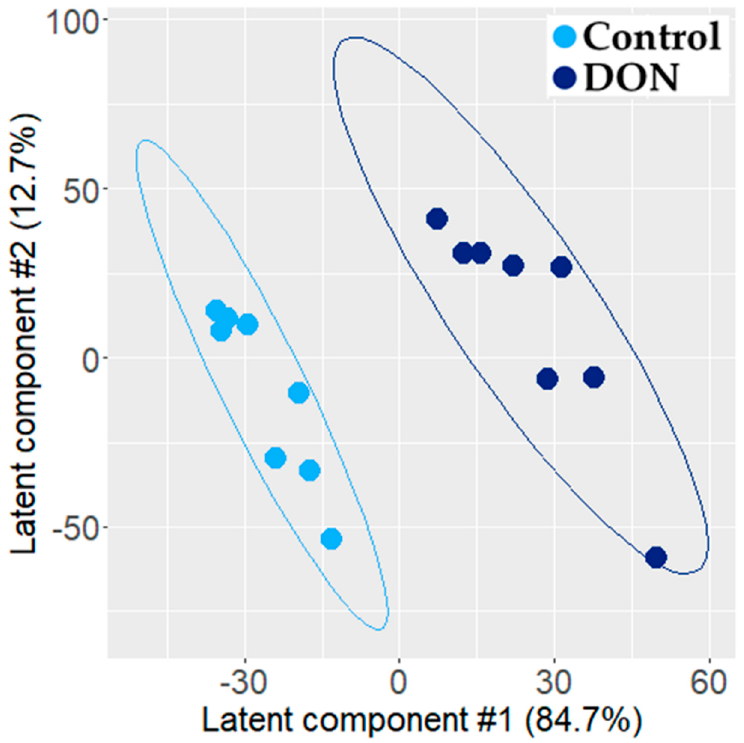
Figure 3. Two-dimensional PLS-DA (R2 = 95% and Q2 = 0.91) score plot of transcriptomic data generated from jejunum explant extracts (control, n = 8, light blue dot; DON-exposed, n = 8, dark blue dot). Each dot corresponds to an individual.